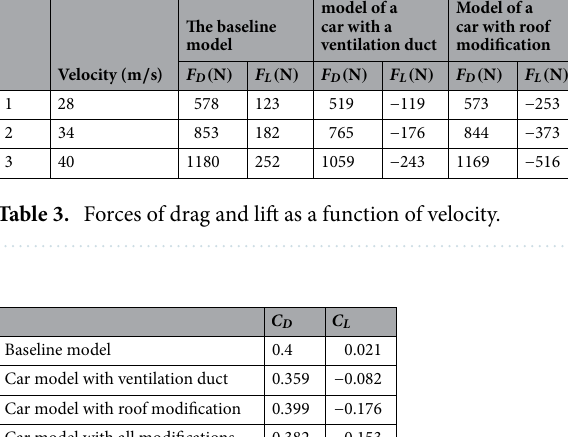
Table 4. Coefficients of lift and drag for all configurations of the Discovery.